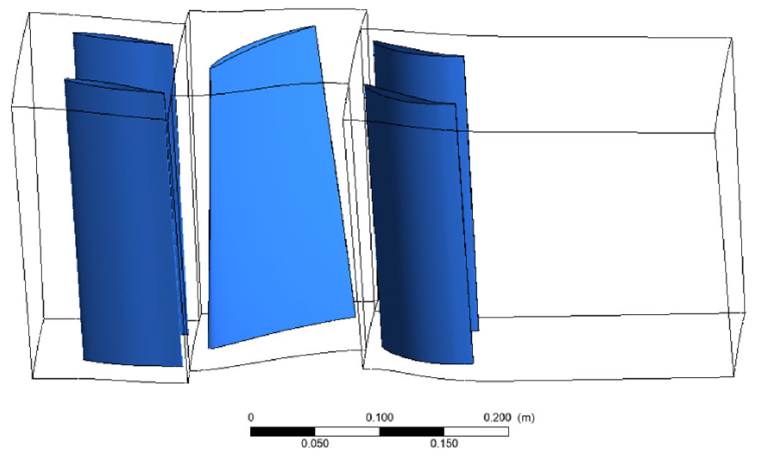
Figure 3. The numerical model.